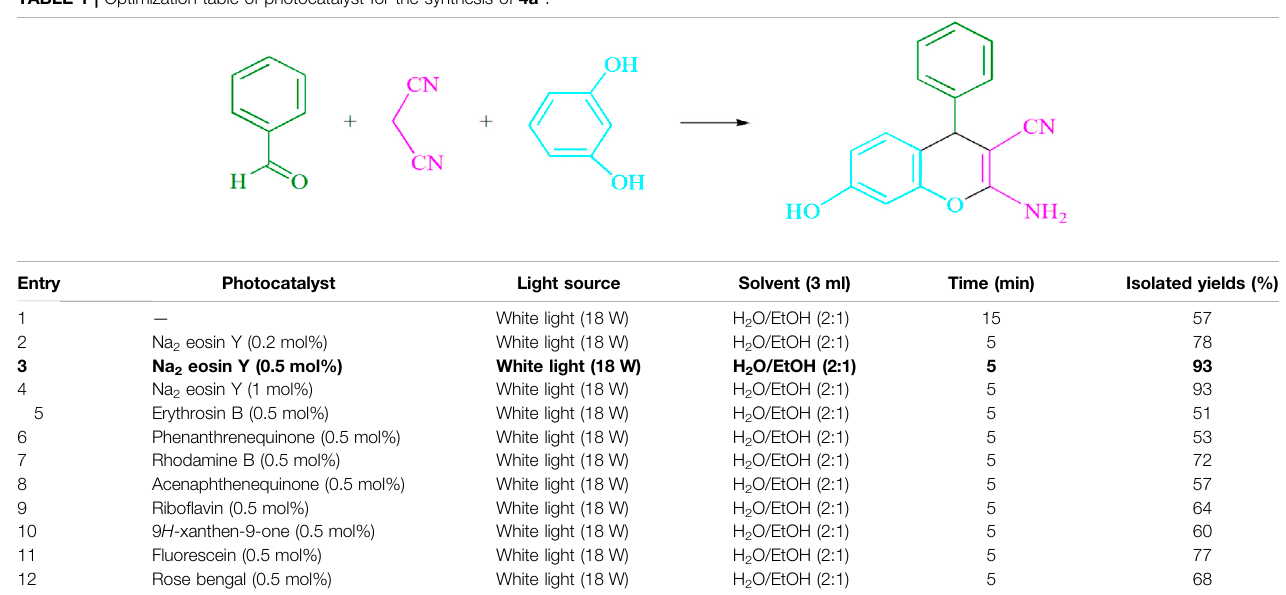
TABLE 1 | Optimization table of photocatalyst for the synthesis of 4a a